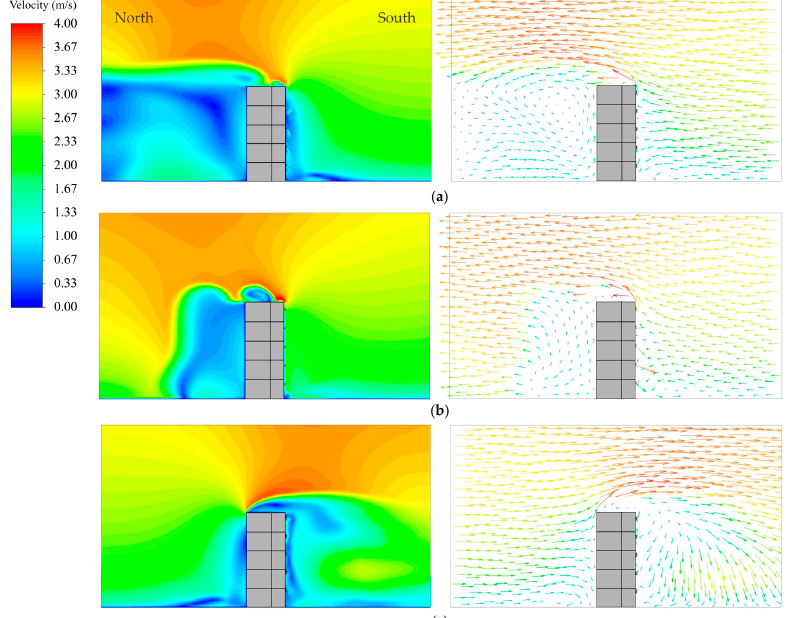
Figure 6. Contour of velocity magnitude and velocity vector (Section-ABCD): ( a ) Case 1; ( b ) Case 4; ( c ) Case 7.